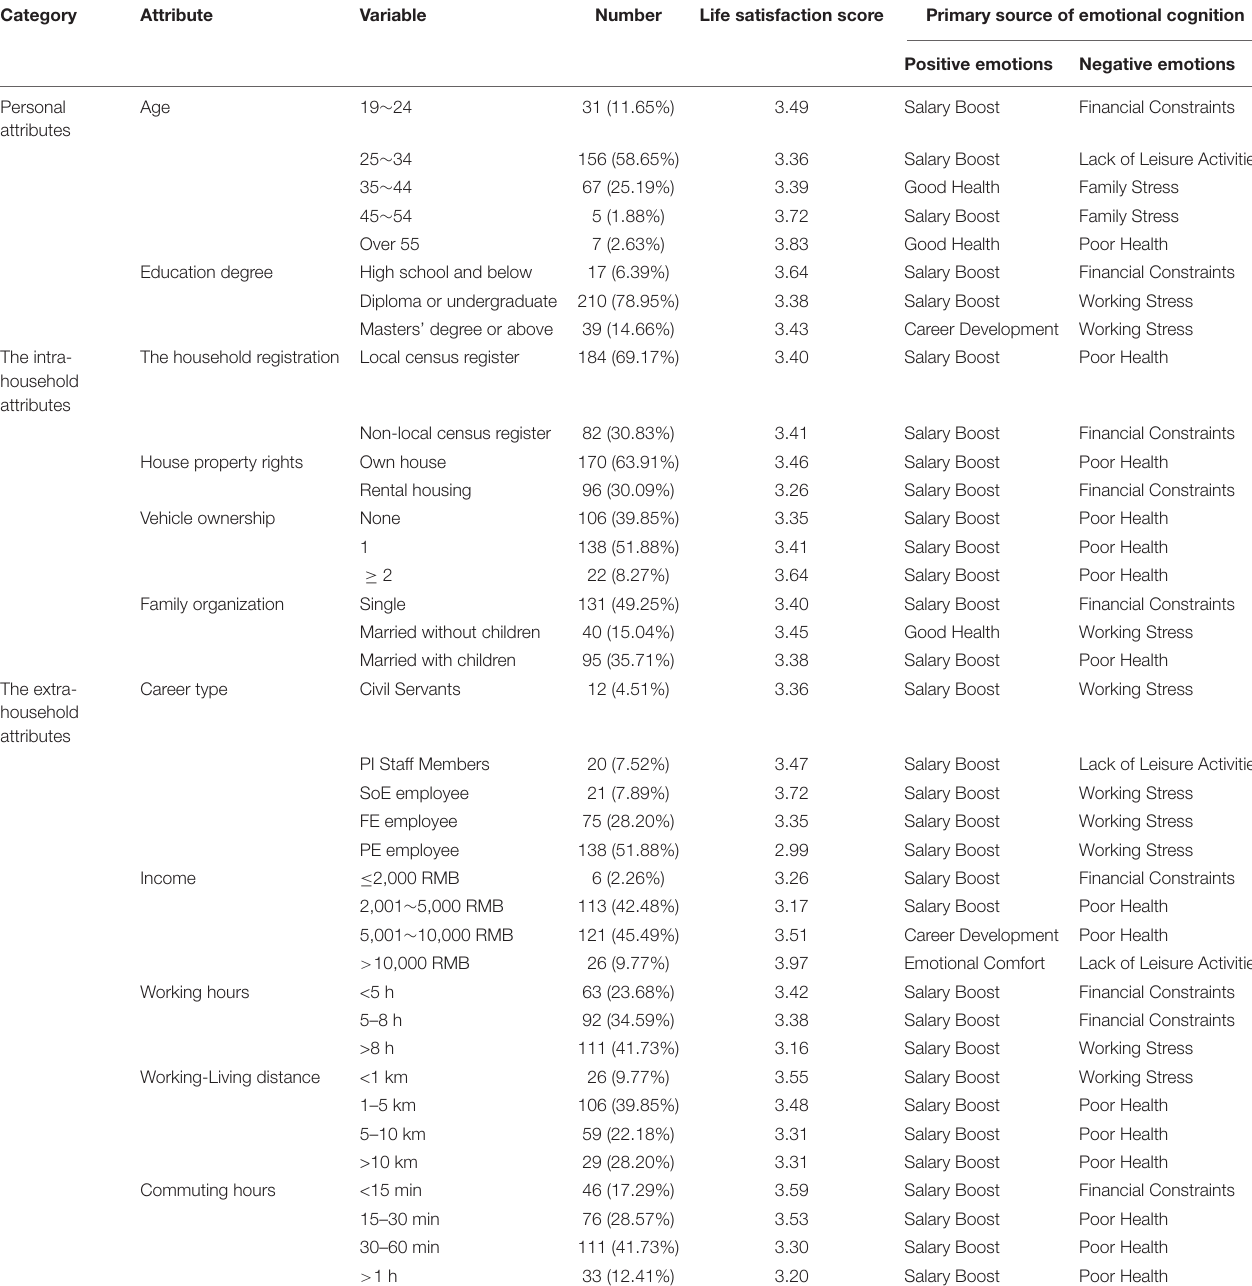
TABLE 1 | Comprehensive evaluation of life satisfaction of professional females.